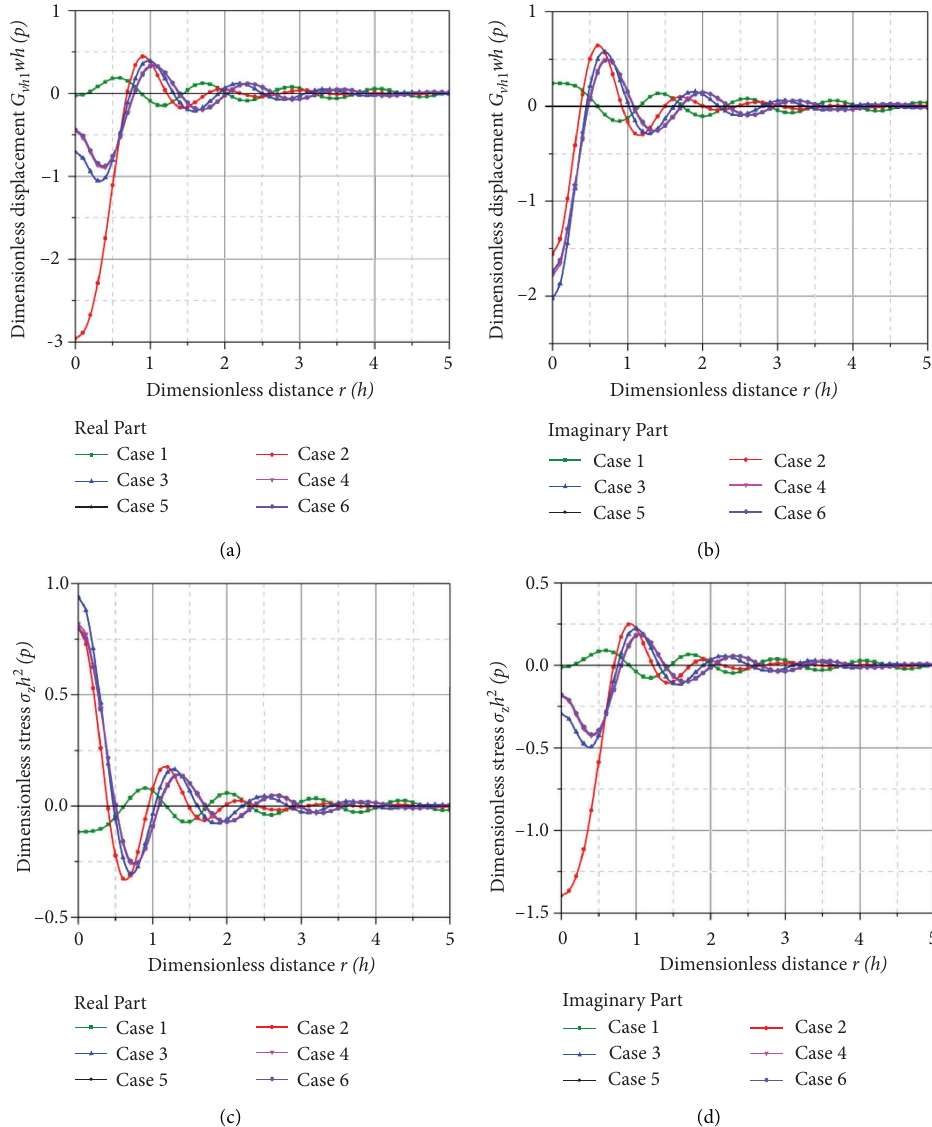
Figure 10: Te vertical displacement and the vertical stress of the medium versus the dimensionless distance for the diferent cases at a fxed dimensionless frequency of two ( ω 0 � 2) and a depth of 0.45m ( z � 0.45m): (a) and (c) are the variation of the real parts; (b) and (d) are the variation of the imaginary